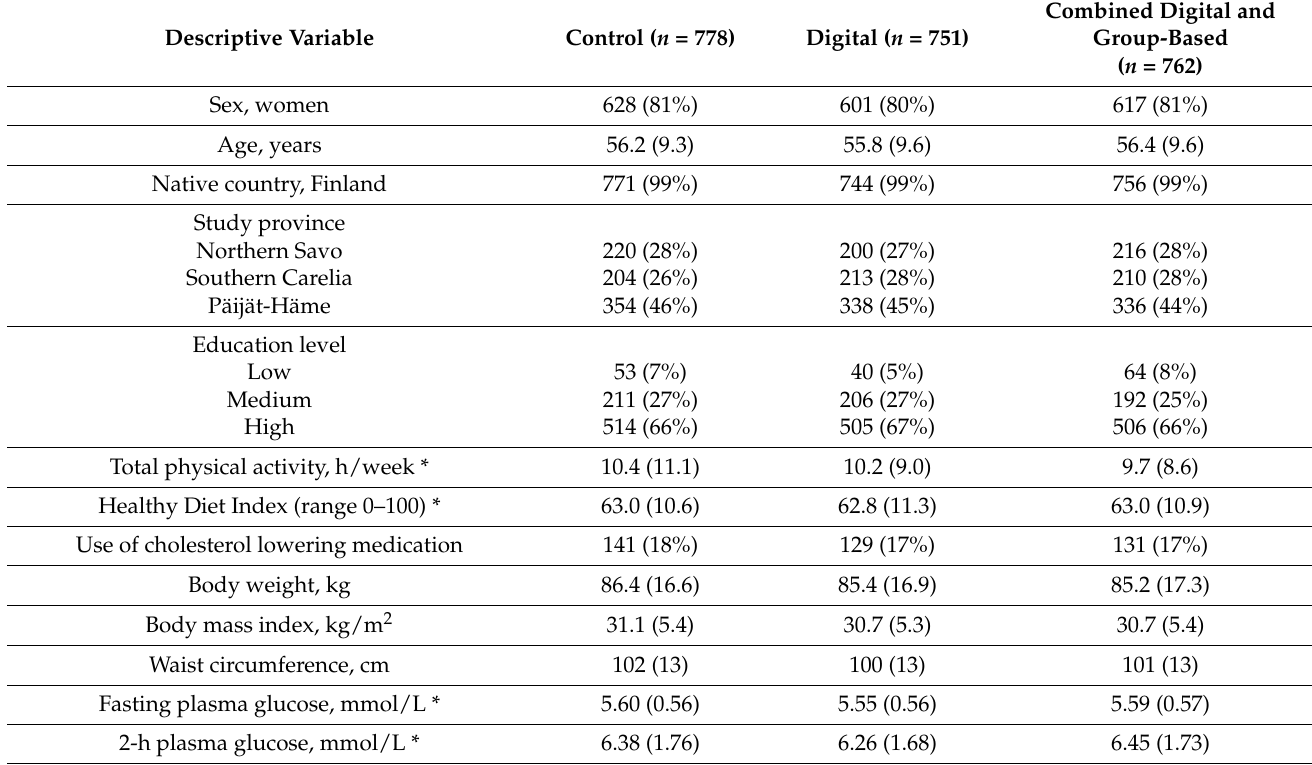
Table 1. Baseline characteristics of